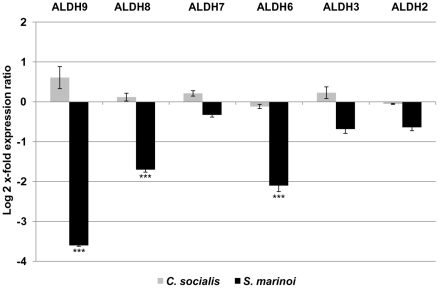
Relative gene expression levels of aldehyde dehydrogenases (ALDH) in the copepod
Calanus helgolandicu
s. Changes in ALDH2, ALDH3, ALDH6, ALDH7, ALDH8 and ALDH9 gene expression levels in C. helgolandicus females fed either unialgal diets of Skeletonema marinoi (S. marinoi) or Chaetoceros socialis (C. socialis) compared to expression levels in females fed on the control Rhodomonas baltica (represented in the figure by x-axis) (*** with p value<0.001, students't-test, GraphPad Software). The ribosomal protein S20 was used as reference gene to normalize the data.